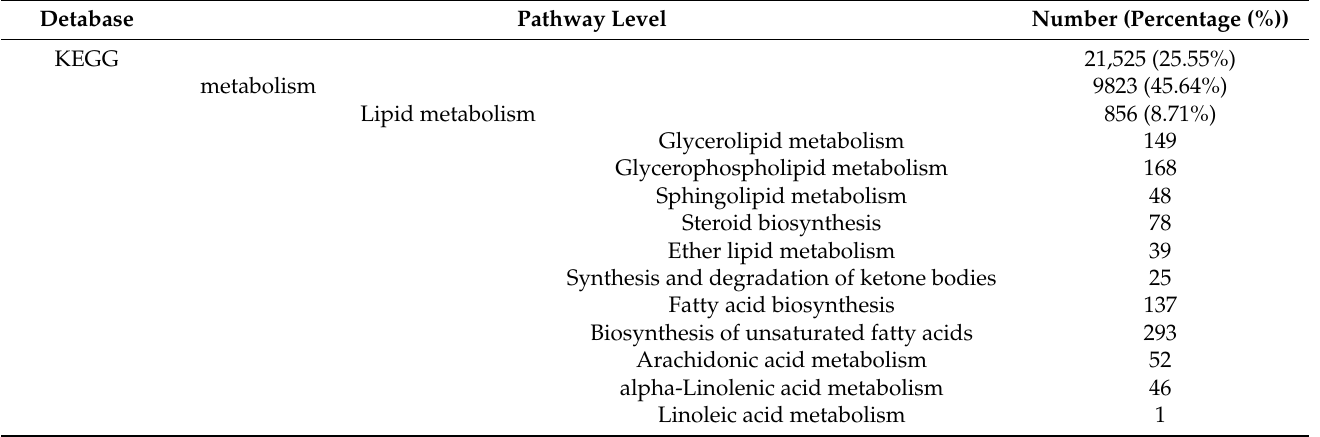
Table 1. Pathways and numbers of genes associated with classification of lipid metabolism.